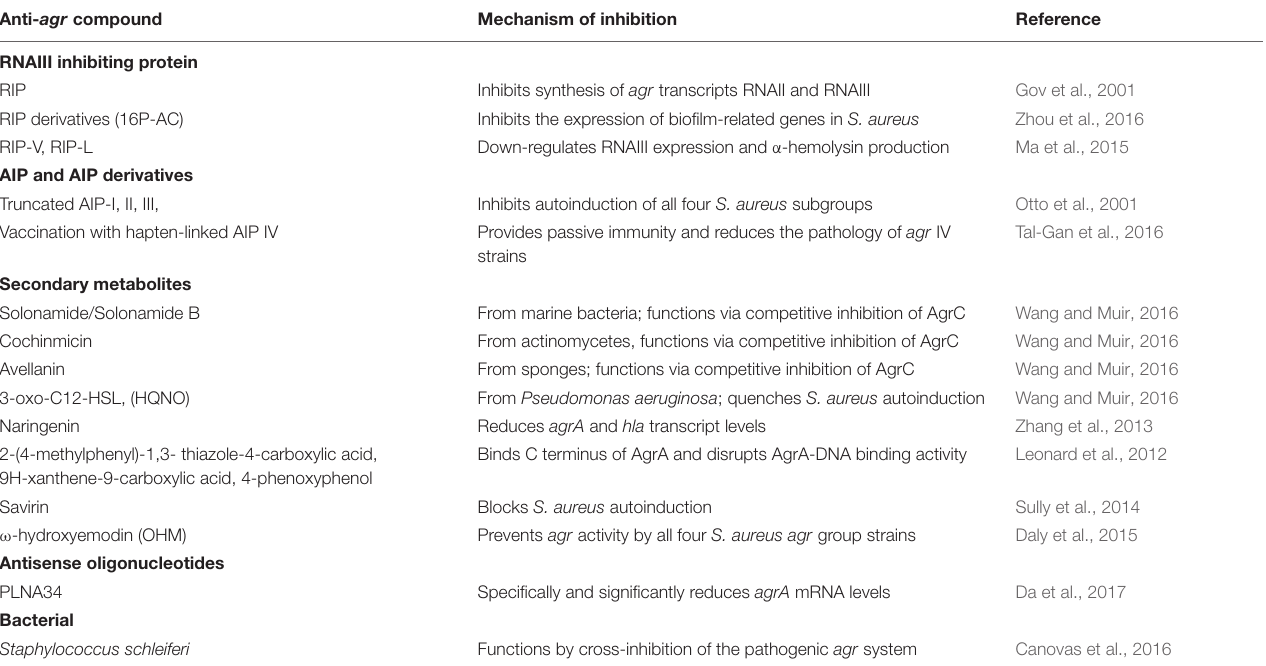
TABLE 1 | Known targets in agr system (target AgrB/D/C/A, RNAIII, and AIP) with the potential to inhibit Staphylococcus aureus